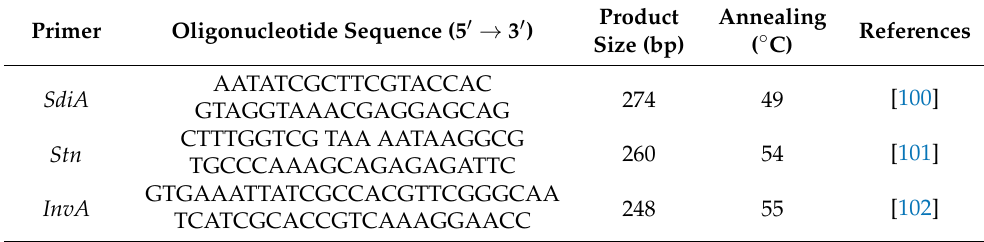
Table 7. Oligonucleotide primers for PCR reactions used for the amplification of the target genes in S. typhimurium isolates.